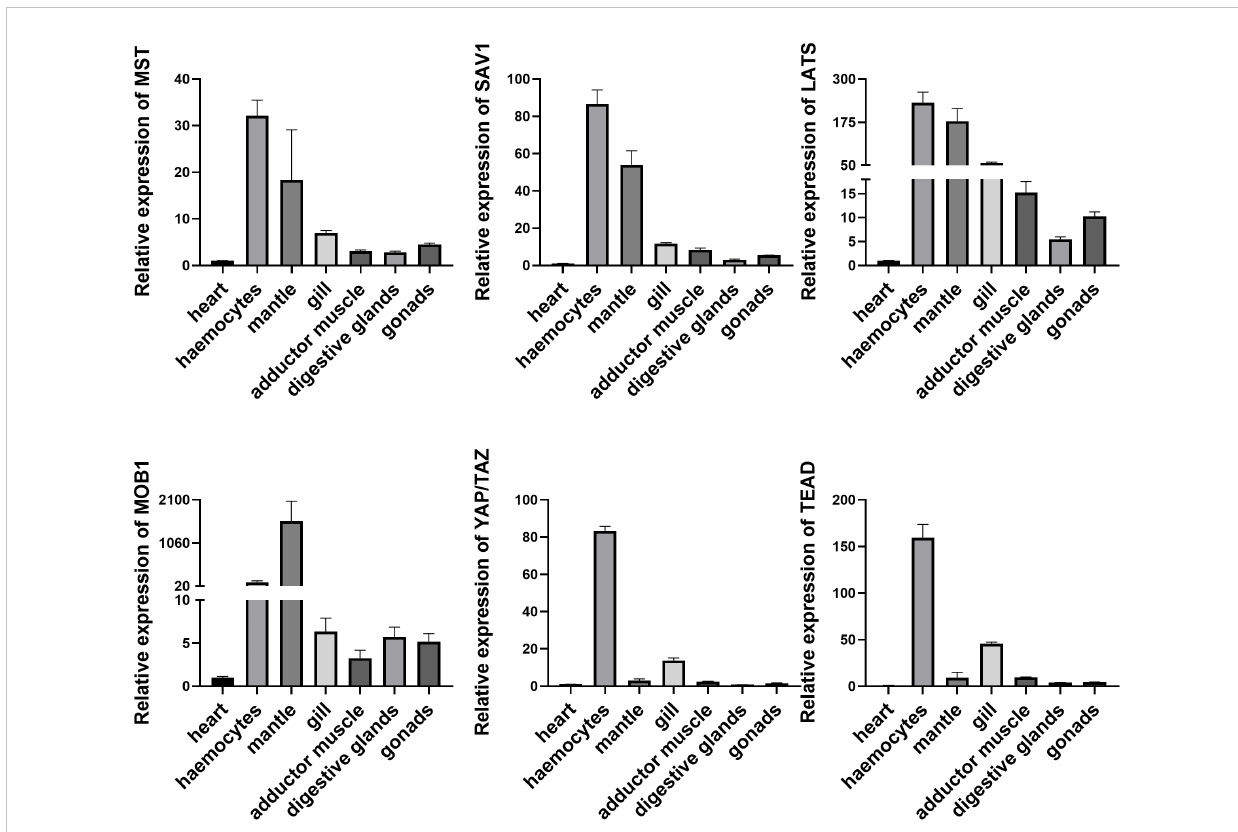
FIGURE 3 Expression pro fi le of Hippo pathway in different tissues. Seven tissues including heart, hemocytes, mantle, gill, adductor muscle, digestive glands, and gonads were examined here. Data analysis was performed by using GraphPad Prism 9 software, and vertical bars represent mean ± SD ( n =